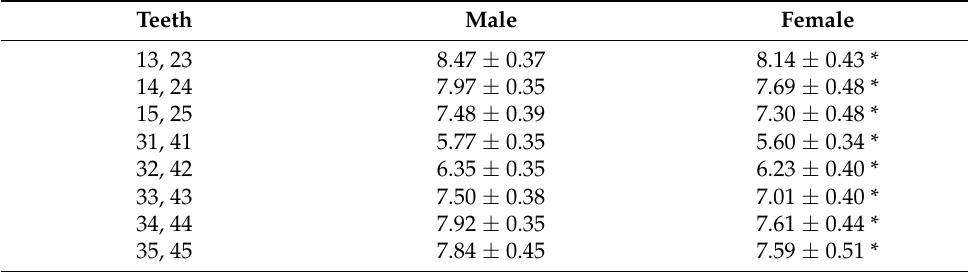
Table 2. Comparison of tooth sizes between males and females.